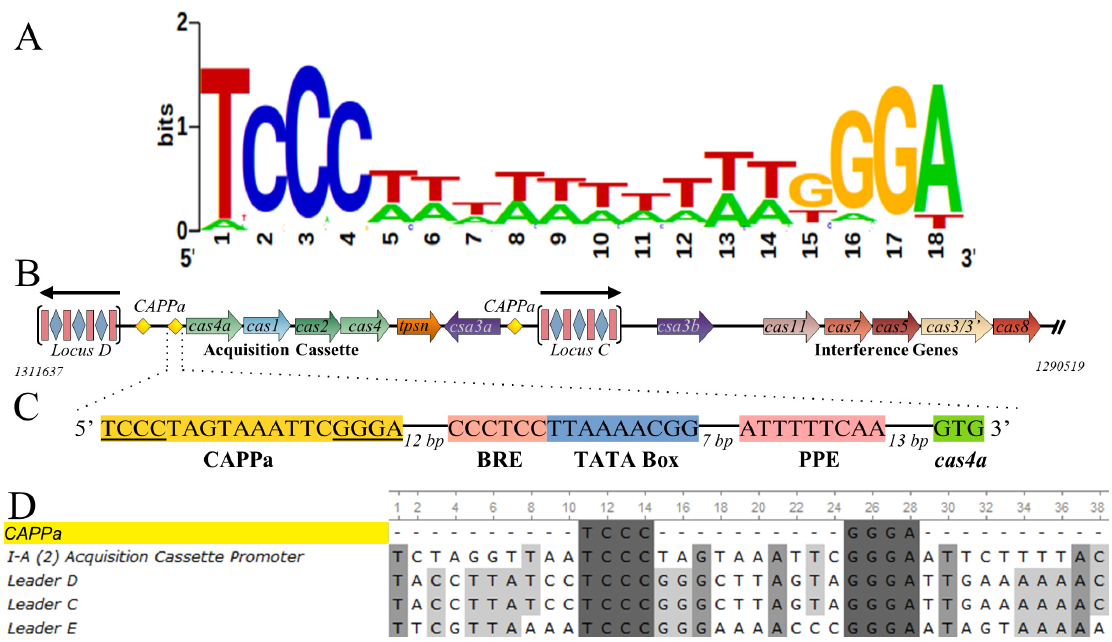
Figure 1. CRISPR-associated palindromes in S. solfataricus. ( A ). Sequence logo for the CRISPR-associated palindrome CAPPa (TCCCN 8 GGGA). ( B ) Organization of 1-A (2) acquisition cassette and adjacent CRISPR loci. CAPPa motifs (yellow diamonds) are found at four locations in the S. solfataricus genome; upstream of the 1-A (2) acquisition cassette as well as CRISPR loci C, D and E. ( C ) CAPPa is immediately upstream of the B recognition element (BRE), the TATA box and the promoter proximal element (PPE). ( D ) CAPPa sequences in S. solfataricus